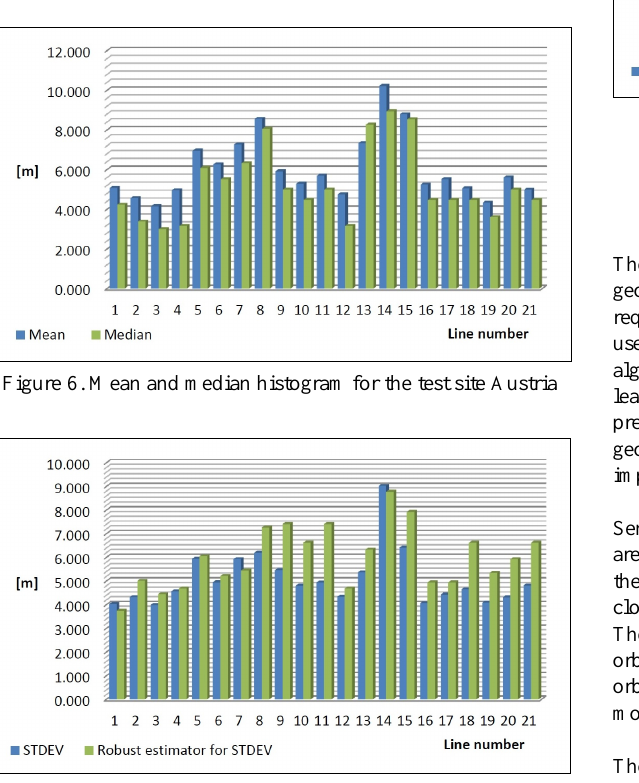
Figure 7. σ and σ MAD histogram for the test site Austria The test field over Serbia revealed the average mismatch between the two datasets of about 12 m which is more than one pixel of a Sentinel-2 image, with a standard deviation of about 8 m. The differences between the mean and the median (Figure 8), as well as the differences between σ and σ MAD (Figure 9) are small in this case as well, so the hypothesis set previously can also be rejected for this test site.